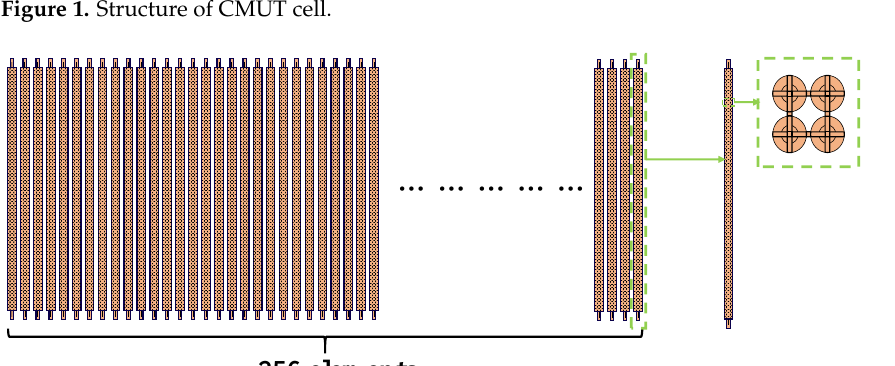
Figure 1. Structure of CMUT cell.